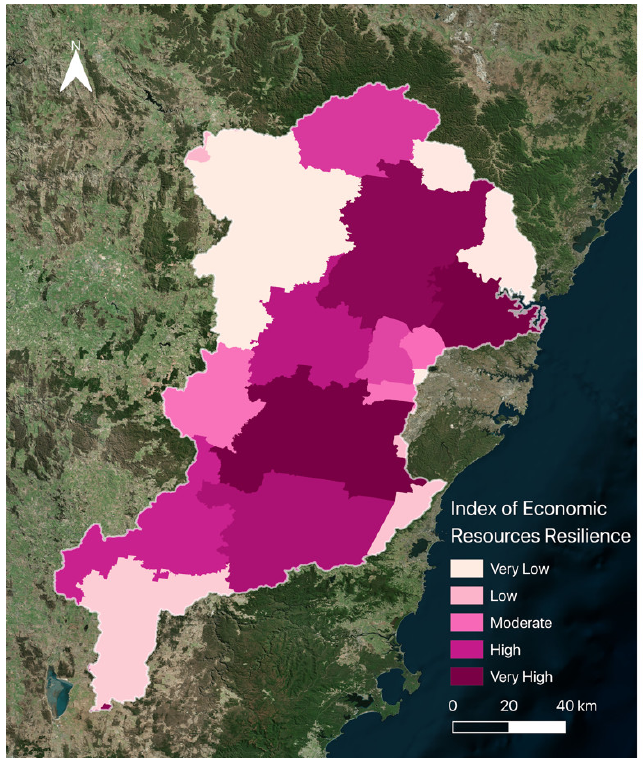
Figure 4. Motor Vehicle Access Resilience after standardising using fuzzy membership processing. Resilience measured from Very Low (light pink) to Very High (dark pink).